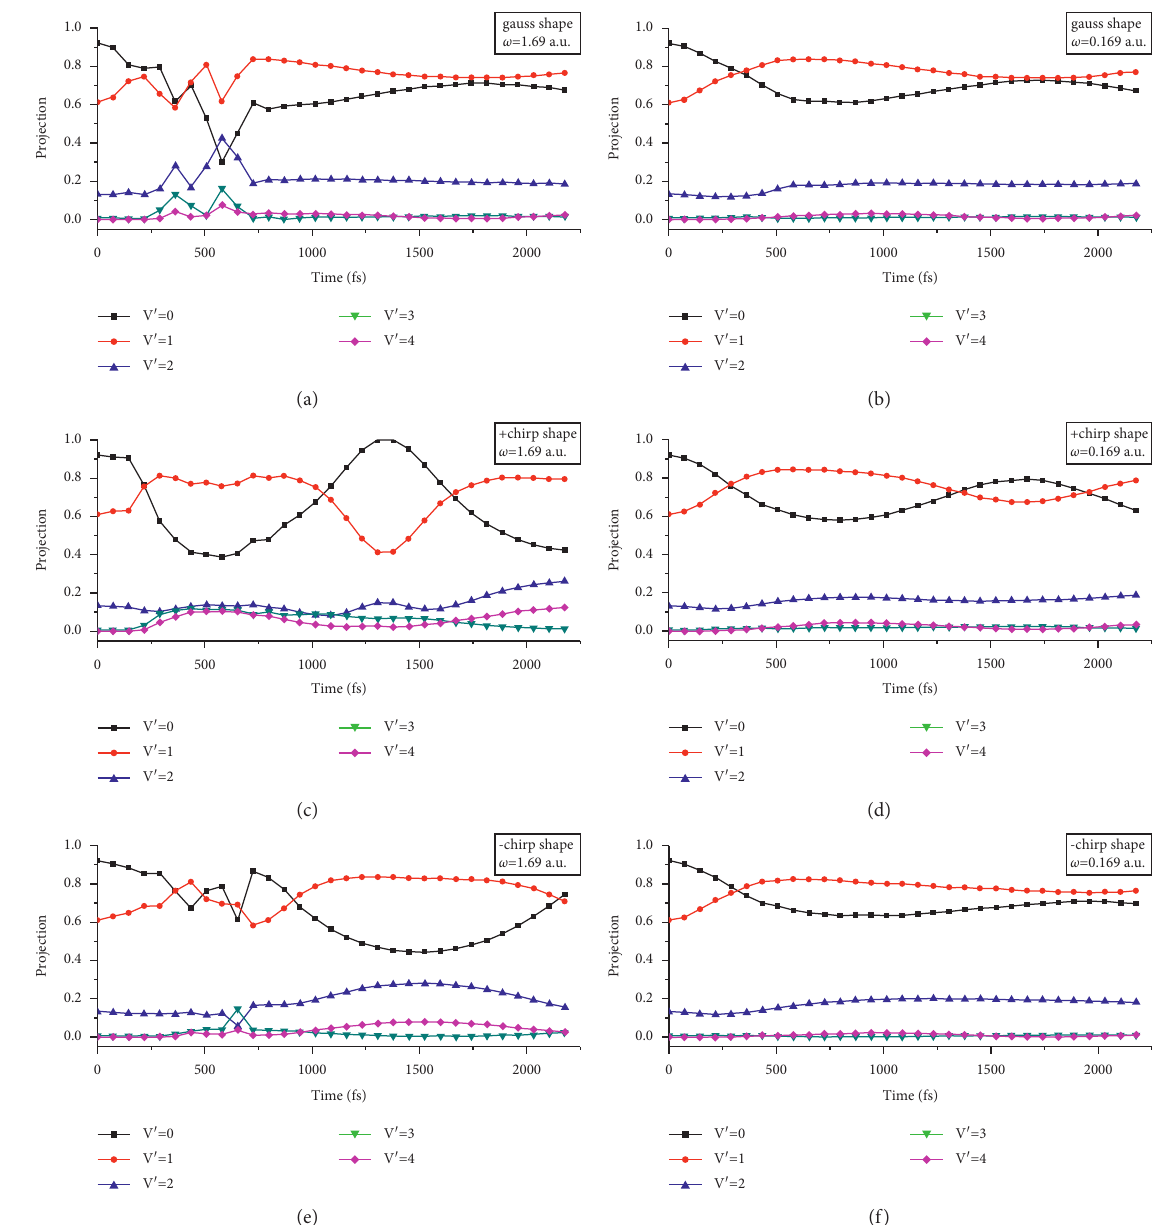
Figure 7: The effect on the projection of the D 1 Π u state by changing pulse shapes and laser intensities: (a, b) Gauss pulse; (c, d) +chirp pulse; (e, f) − chirp